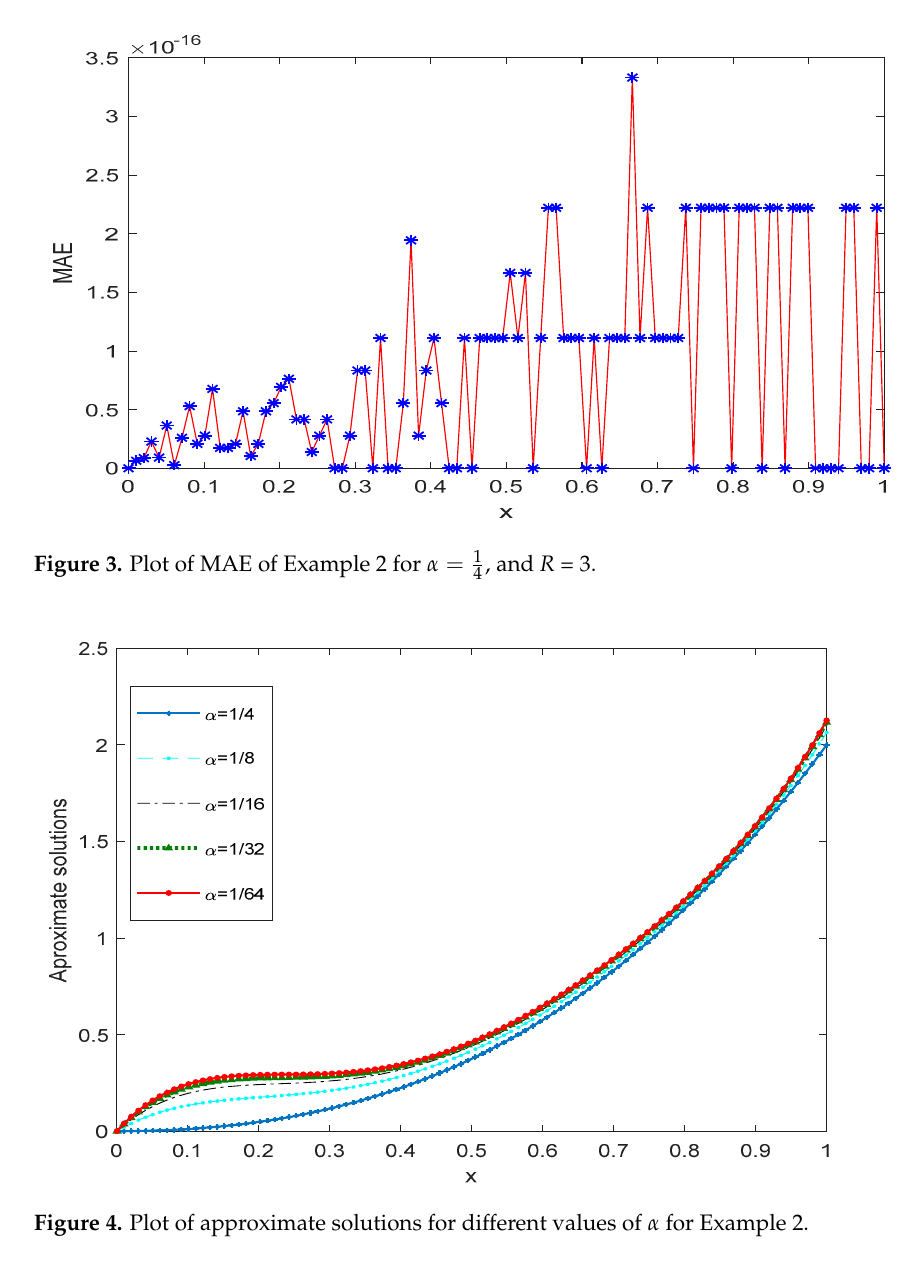
Figure 4. Plot of approximate solutions for different values of 𝛼 for Example 2.